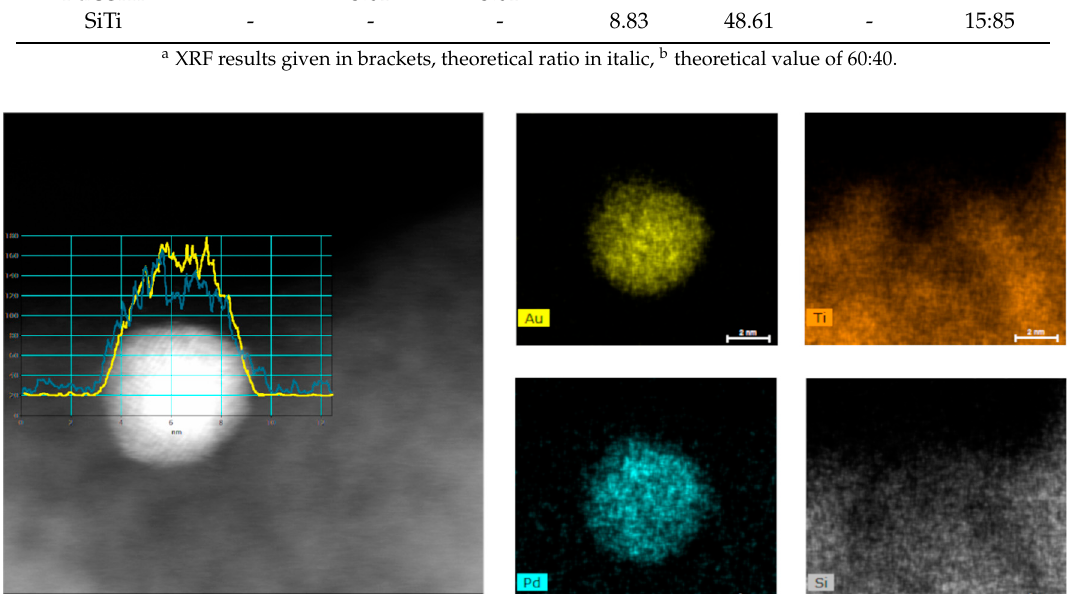
Figure 2. Transmission electron microscopy (TEM) images of ( a ) bare SiTi; ( b ) Au@SiTi; ( c ) Pd@SiTi; ( d ) Au 4 Pd 1 @SiTi; ( e ) Au 1 Pd 1 @SiTi; ( f ) Au 1 Pd 4 @SiTi; ( g ) Au 1 Pd 1 @SiTi; ( h ) Au 1 Pd 1 @SiTi in dark field measurement and ( i ) preformed Au 1 Pd 1 nanoparticles stabilized by sodium citrate and used for the embedded catalysts synthesis.